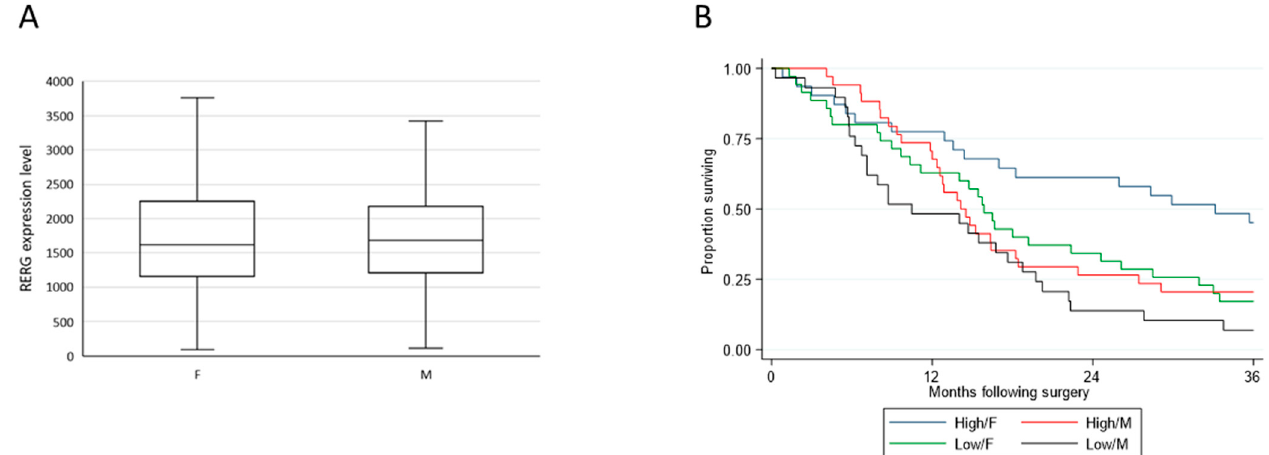
Figure 3. RERG analyses in relation to sex ( A ) and survival ( B ) in the Affymetrix cohort. Box plots (outliers not shown) illustrating RERG expression for female ( n = 66) and male ( n = 63) MPM patients ( A ). Kaplan-Meier curves of overall survival according to sex and RERG expression ( n = 129) ( B ). Green and blue indicate low and high RERG expression in women, respectively, whereas black and red indicate low and high RERG expression in men. Overall survival was calculated from date of surgery. Survival curves were truncated at 36 months.